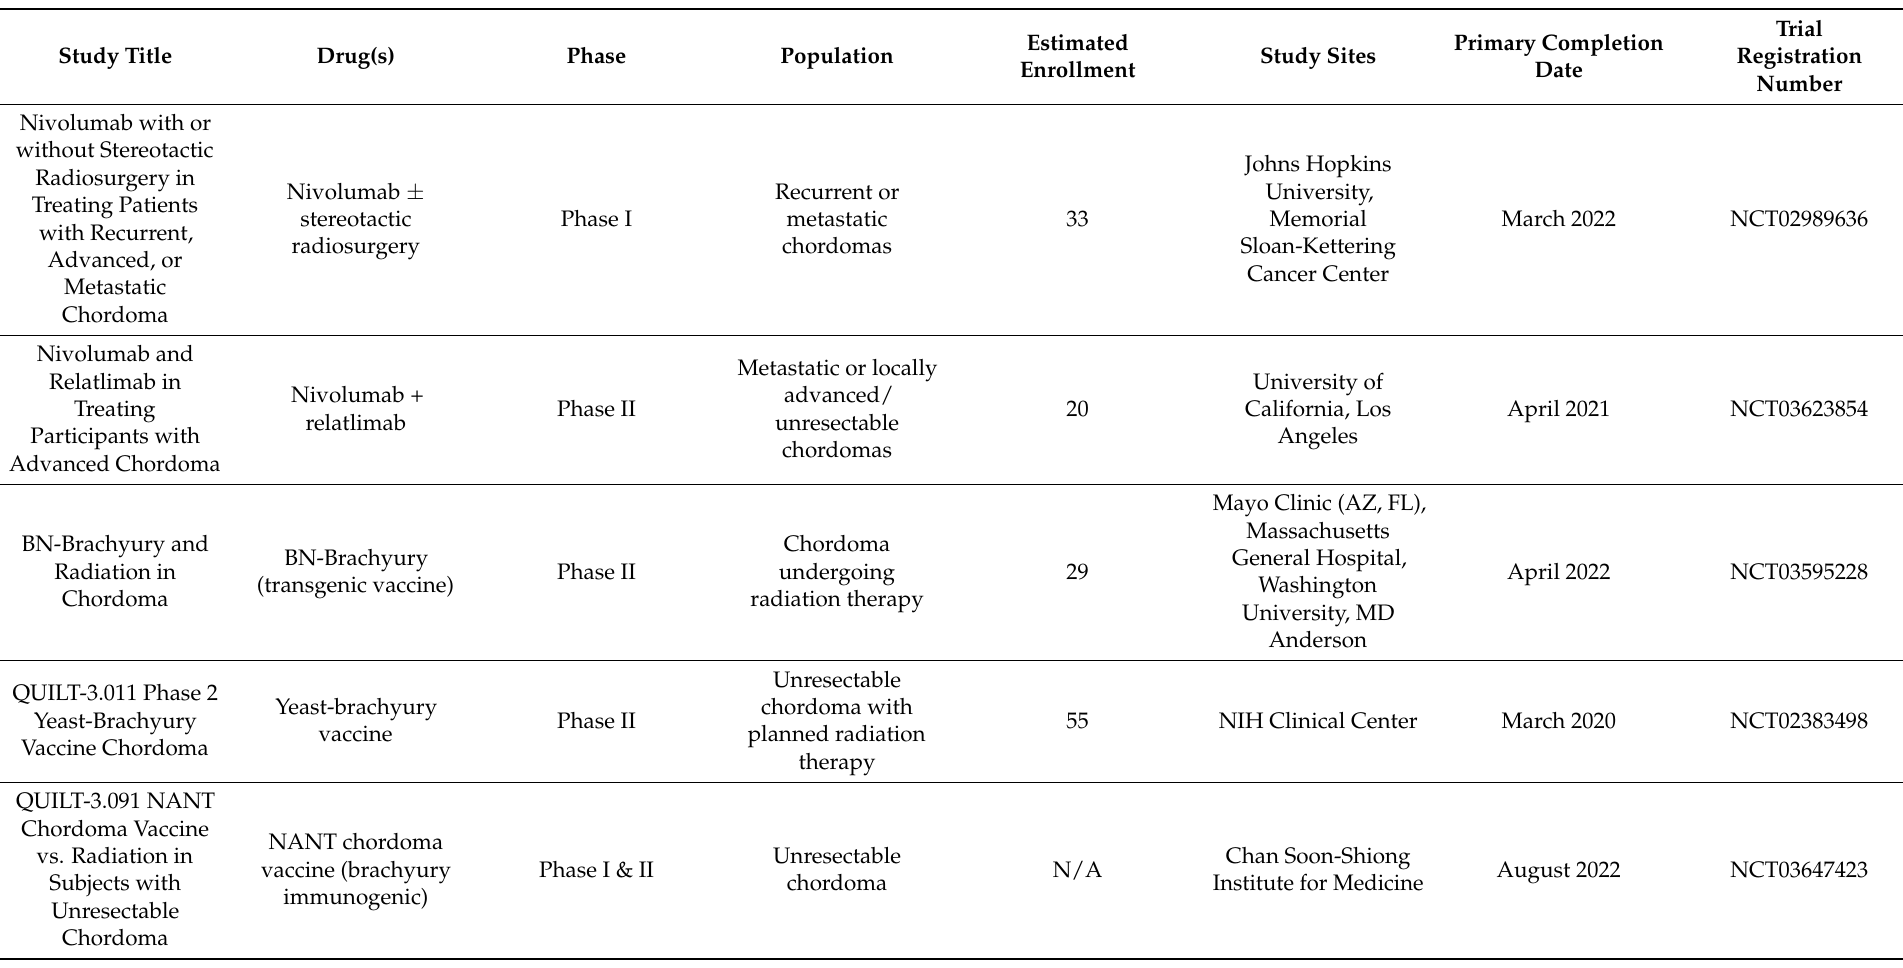
Table 1. Ongoing chordoma and chondrosarcoma immunotherapy clinical